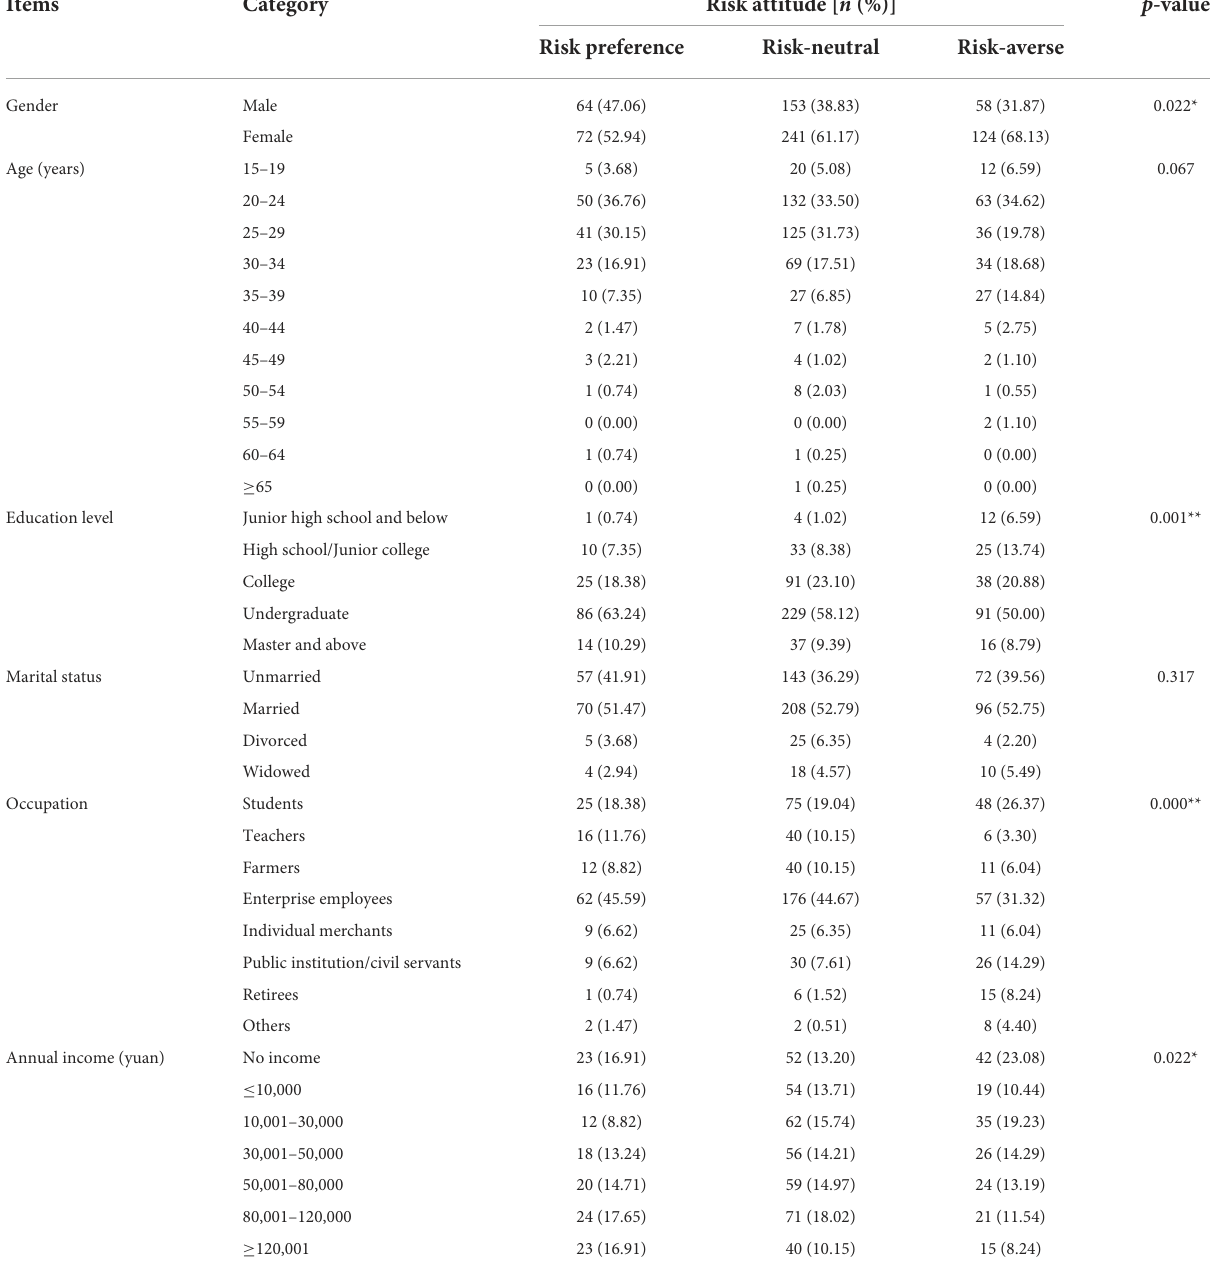
TABLE 3 Sociodemographic and risk attitude variability analysis ( N =